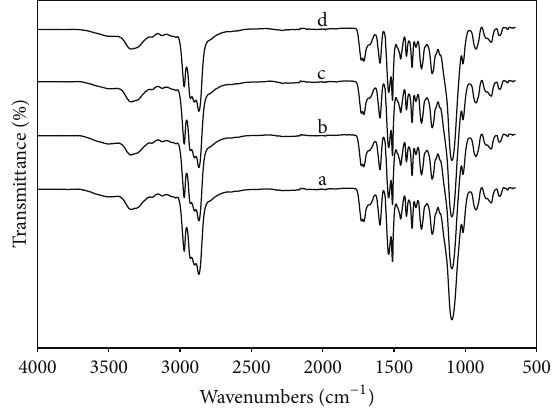
Figure 7: FTIR spectra of (a) palm-based PU foam and PU bionanocomposite foams with (b) 3wt% OMMT, (c) 5 wt% OMMT, and (d) 7 wt% OMMT.